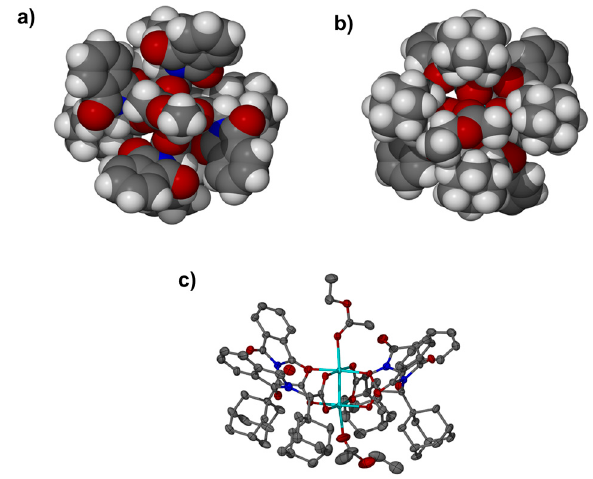
Figure 4. Space filling structure of bis(EtOAc) adduct of Rh 2 ( S -PTAD) 4 viewed along the Rh-Rh axis ( a ) into the chiral crown cavity, ( b ) onto the achiral Rh coordination site shrouded by the adamantyl groups. ( c ) Side view of bis(EtOAc) adduct of Rh 2 ( S -PTAD) 4 . (Adapted from Adly, F.G.; Gardiner, M.G.; Ghanem, A. Chem. Eur. J. 2016 , 22 , 3447, Copyright 2017, with permission from John Wiley and